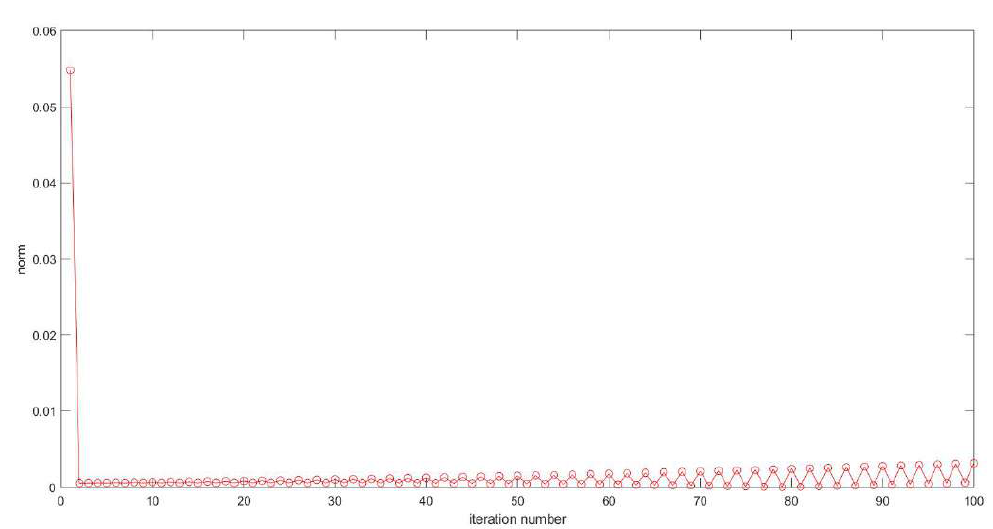
Figure 5. Norm of solution u of (24)–(26) under TTC control with τ = 0.1, and λ = − 0.9.